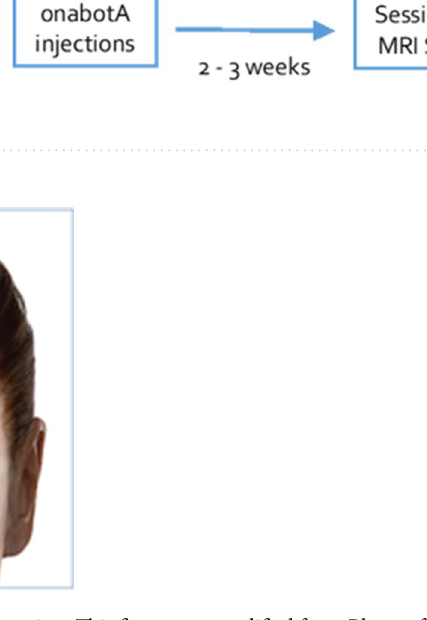
Figure 2. OnabotulinumtoxinA injection sites. This figure was modified from Blumenfeld and colleagues 60 under a Creative Commons license (CC BY-NC